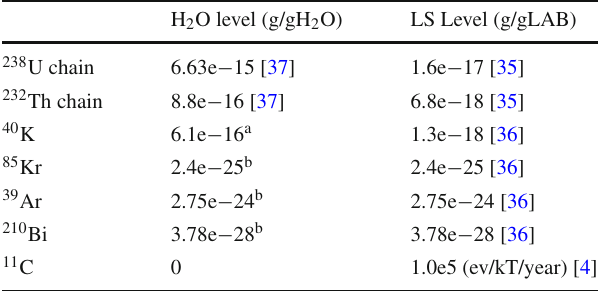
number of detected PMT hits per MeV of deposited energy, thus scaling both Cherenkov and scintillation contributions.